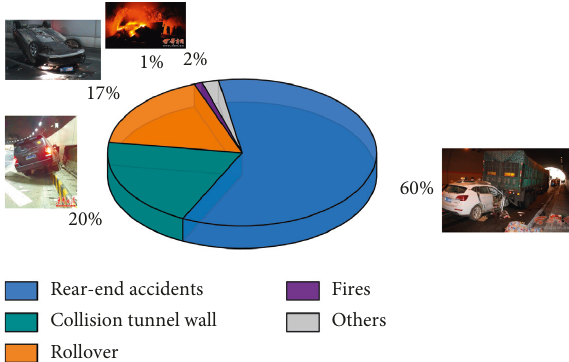
Figure 4: Accident types versus traffic